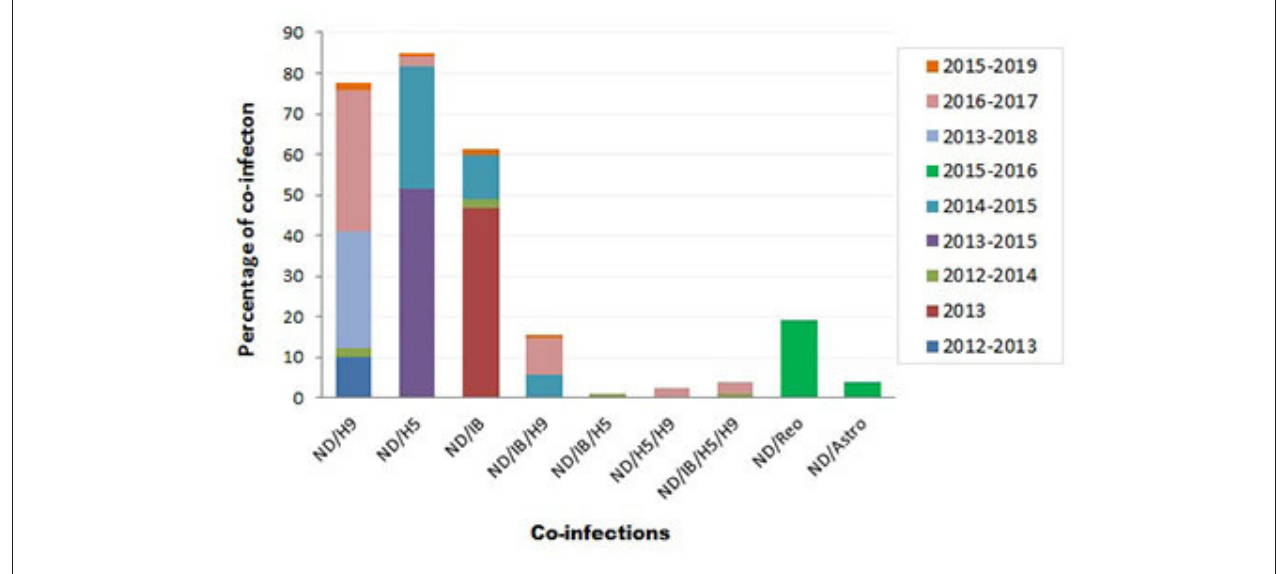
FIGURE 3 | Summary of Newcastle disease virus (NDV) co-infection records with different infectious agents in